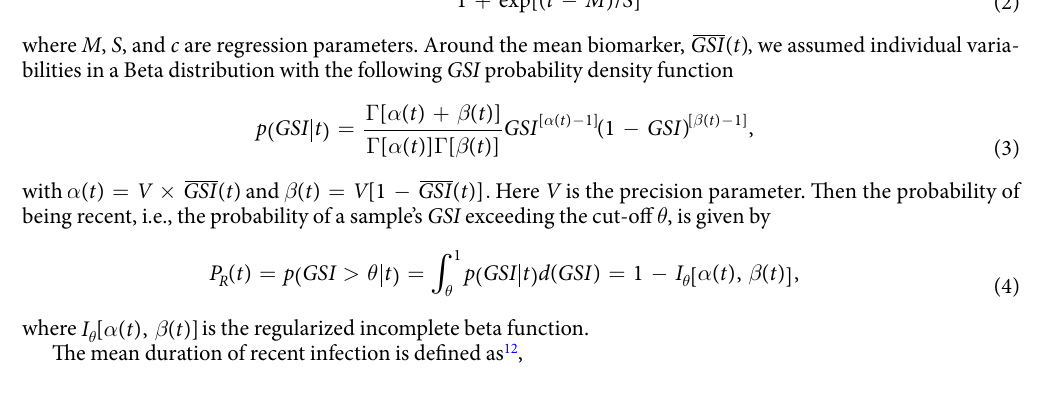
is an indicator function. Recent infections would ij